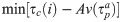
All six conditions htp comparision.The plot of the collection of slopes which is obtained in Fig 5 and S1 to S6 Figs supplementary figures. The condition-wise comparison of the change of participants htp with co-worker htp. P-values are Bonferroni corrected where required. The tangent slope at the minimum data abscissa value (min[τc(i)-Av(τpa)]) was collected across participants (as shown in Fig 5), checked for normality using the Shapiro-Wilk test and then analyzed for difference from zero using a one sample T-test (in case the distribution was normal) or a Signed Rank test.